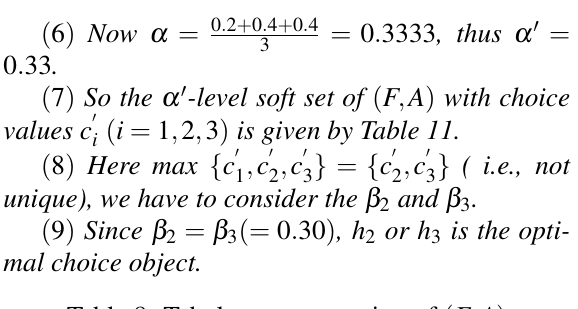
Table 8: Tabular representation of ( F , A ) e 1